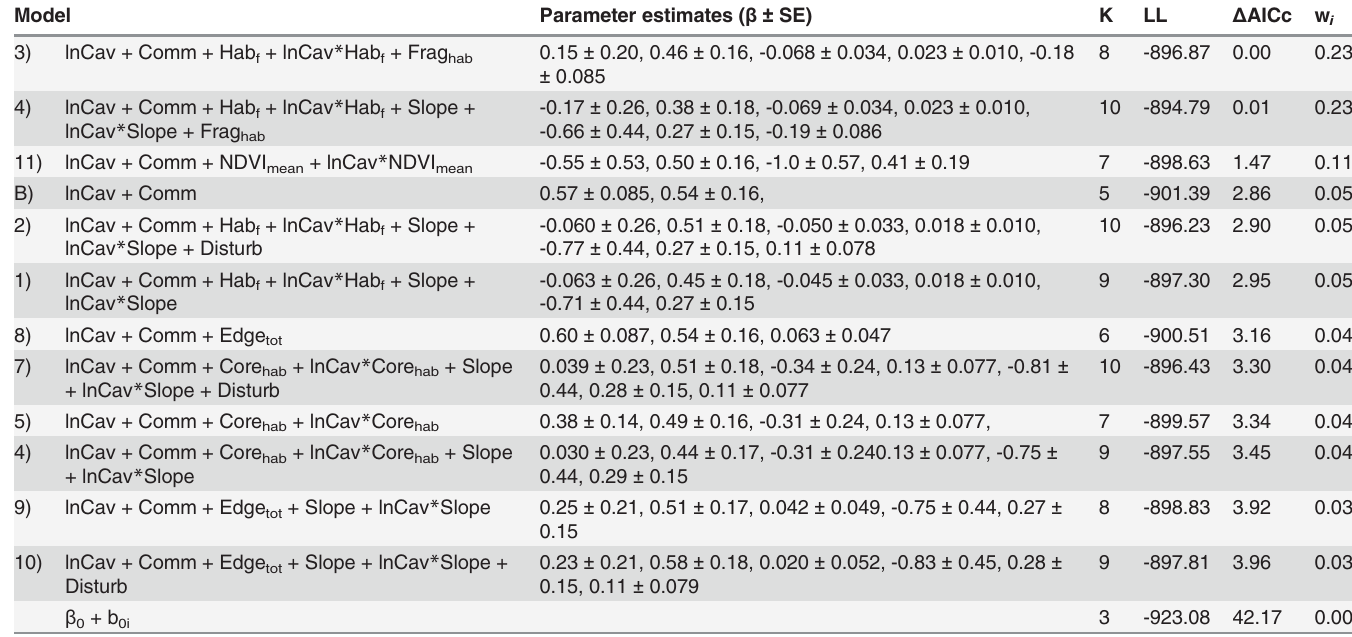
Table 3. Rankings and estimated slope parameters for hypothesized models that explained the effects of habitat factors on reproductive output of ferruginous pygmy-owls in northwest Mexico, 2001 – 2010.